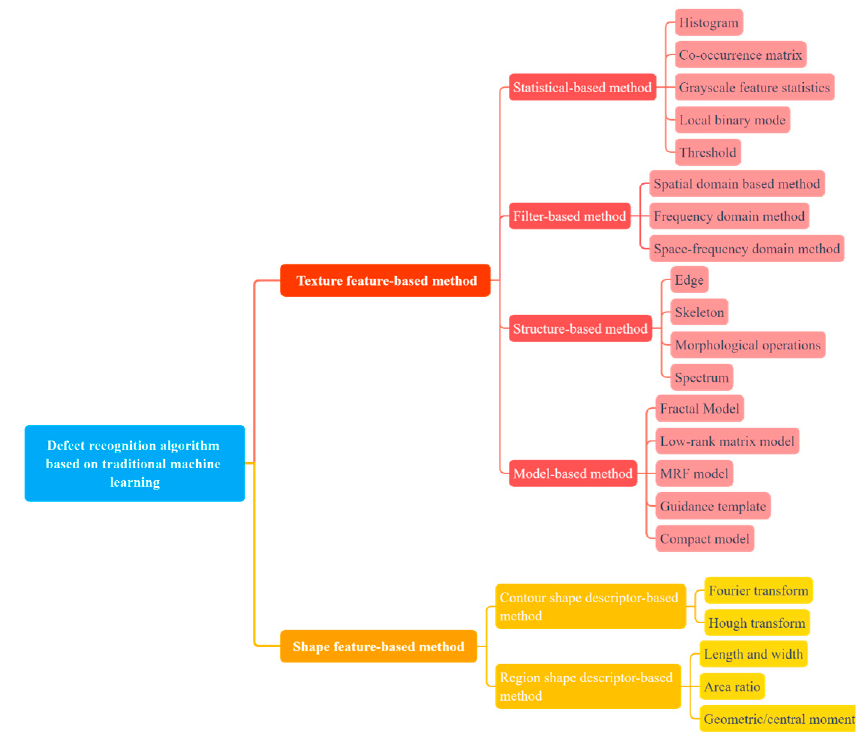
Figure 4. Classification of traditional machine learning methods.